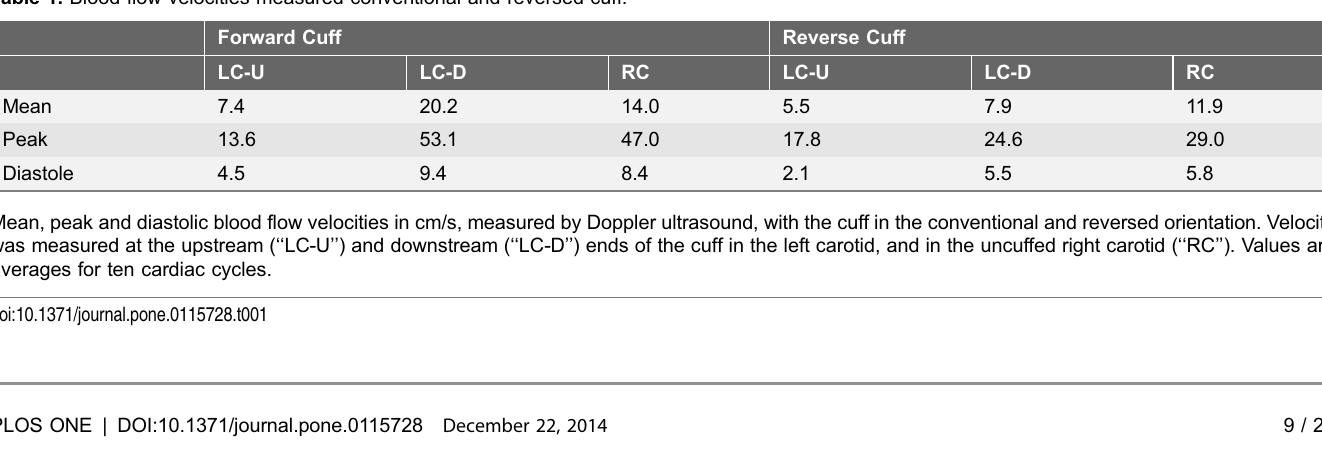
Table 1. Blood flow velocities measured conventional and reversed